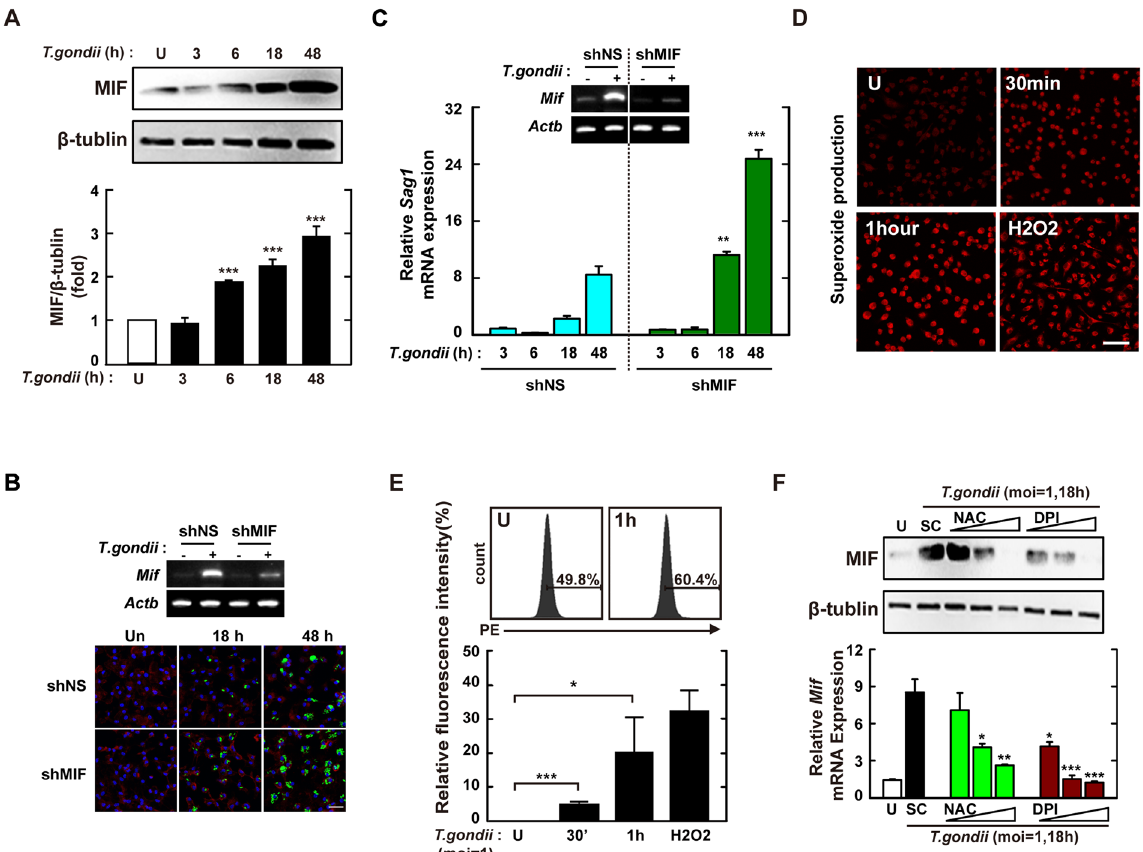
Figure 1. MIF expression via intracellular ROS generation is required for the inhibition of intracellular proliferation in T . gondii -infected macrophages. ( A ) BMDMs were infected with T . gondii RH strain (moi = 1) for the indicated time periods and then cell lysate was collected. Immunoblot analysis was performed for protein expression of MIF or β -tubulin. Upper panel , Representative gel image. Lower panel , Densitometry. ( B , C ) BMDM were transduced with lentiviruses expressing shNS or shMIF at a multiplicity of infection (MOI) of 5 for 48 h with polybrene (8 μ g/mL) and then infected with GFP-RH strain (for B) or T . gondii RH strain (for C) for the indicated time periods. The mRNA expression for Mif and Actb was determined using semiquantitative RT-PCR ( B ) Cells were fixed and stained with Texas Red ® -X phalloidin for labeling F-actin (red) for cytosolic fraction, and DAPI (blue) for nuclei and then analyzed for the number of GFP-RH strain using confocal microscopy (bottom) ( C ) Quantitative real-time PCR analysis were assessed to determine sag1 mRNA expression in whole-cell lysates. ( D , E ) BMDMs were infected with T . gondii RH strain (moi = 1) for indicated times and then stained with DHE (2 μ M) for 15 min. Intracellular ROS generation was measured using confocal microscopy (for D) and flow cytometery (for E). Scale bar = 50 μ m. H 2 O 2 (1 mM, 30 min) was used for positive control. ( F ) Immunoblot (top) or qPCR (bottom) analysis of MIF expression in BMDMs after T . gondii RH strain infection (moi = 1, 18 hr) in the presence or absence of general antioxidant (NAC; 1, 2, or 5 mM) or Nox inhibitor (DPI; 1, 5, or 10 μ M). Data are representative of three independent experiments and are presented as means ± SD. * P < 0.05, ** P < 0.01, *** P < 0.001, two-tailed Student’s